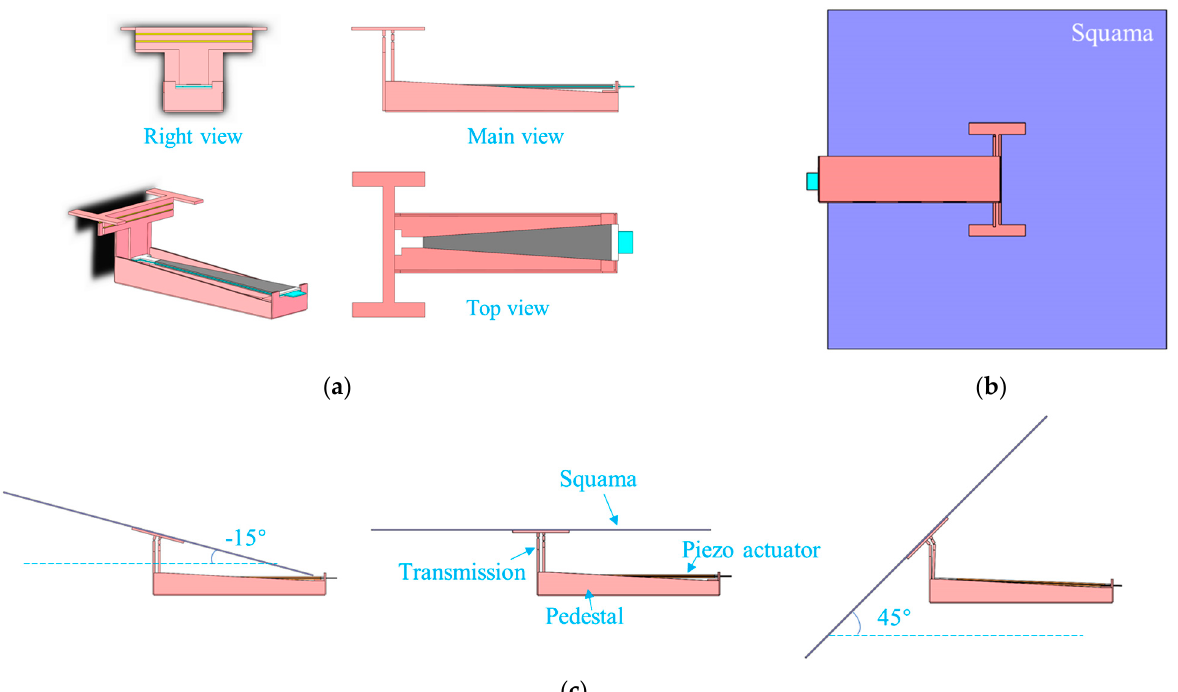
Figure 2. Deformable squama mechanics: ( a ) view of the deformed mechanics in three directions; ( b ) deformable mechanics model with squama installed; ( c ) deflection range of deformed squama, − 15 ◦ –45 ◦